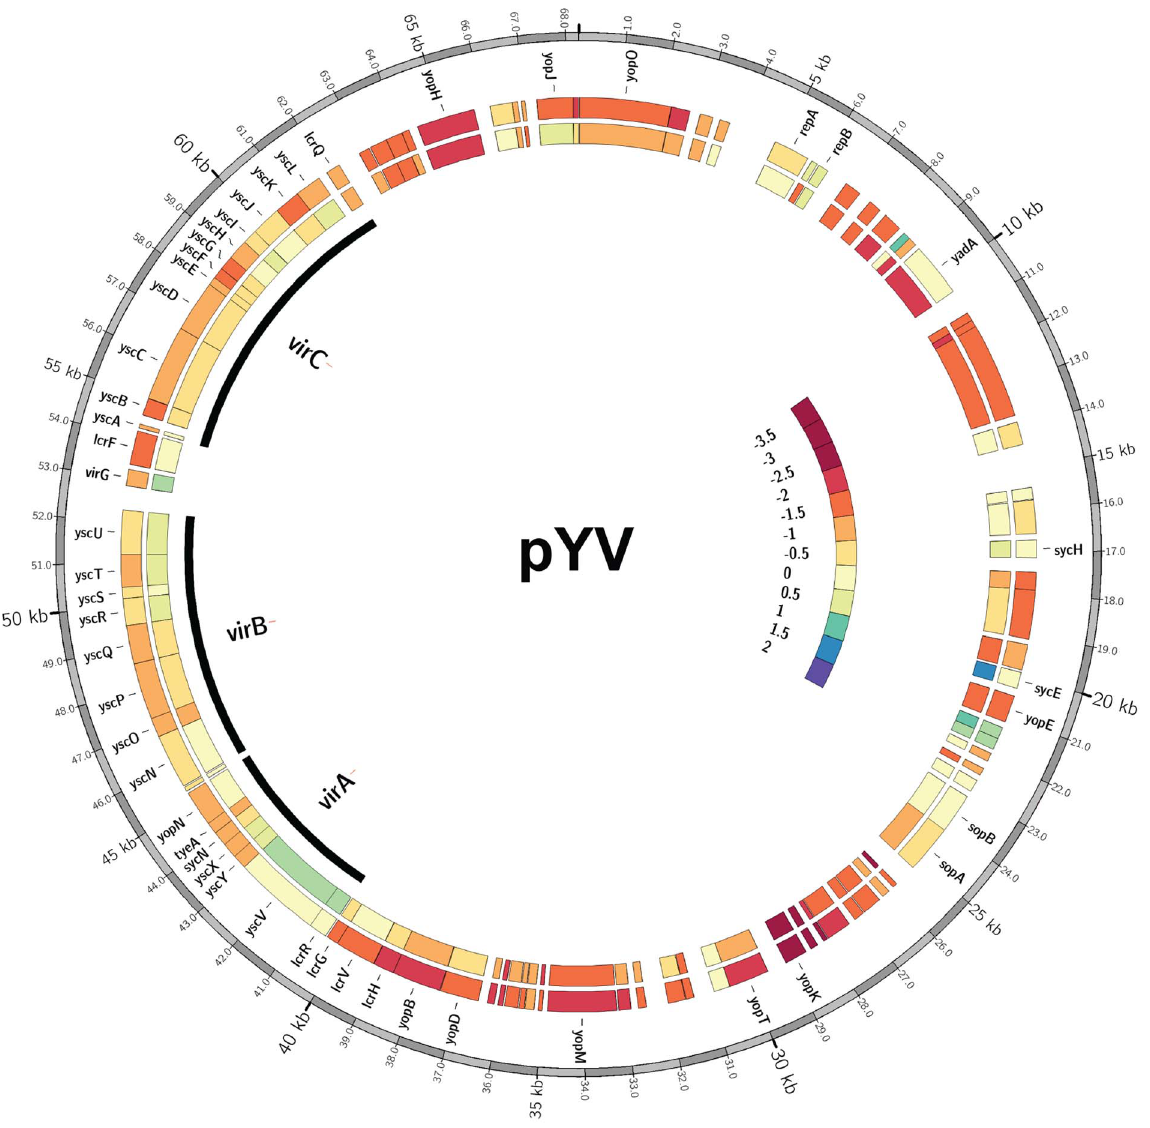
Figure 7. Y.pseudotuberculosis lacking a functional IscR display decreased transcription of a number of pYV encoded genes. Middle and inner rings: heatmap [83] representations of log 2 -ratios (log 2 (RPKM mutant /RPKM wt ) for each gene on the pYV plasmid for both the D iscR (middle ring) and apo-IscR (inner ring) mutants relative to wild type. Outer ring: pYV base coordinate position from Y. pseudotuberculosis IP32953. Known genes are identified and the virA , virB and virC operons highlighted by black arcs. On the interior right side is the color bar legend displaying log 2 - ratios from 2 3.5 to 2. Using this scale, orange/red colorations represent genes with decreased transcription in the mutant relative to the wild type strain and blue/green coloring represents increases in gene transcription for the mutant relative to the wild type. Tan/cream denotes no